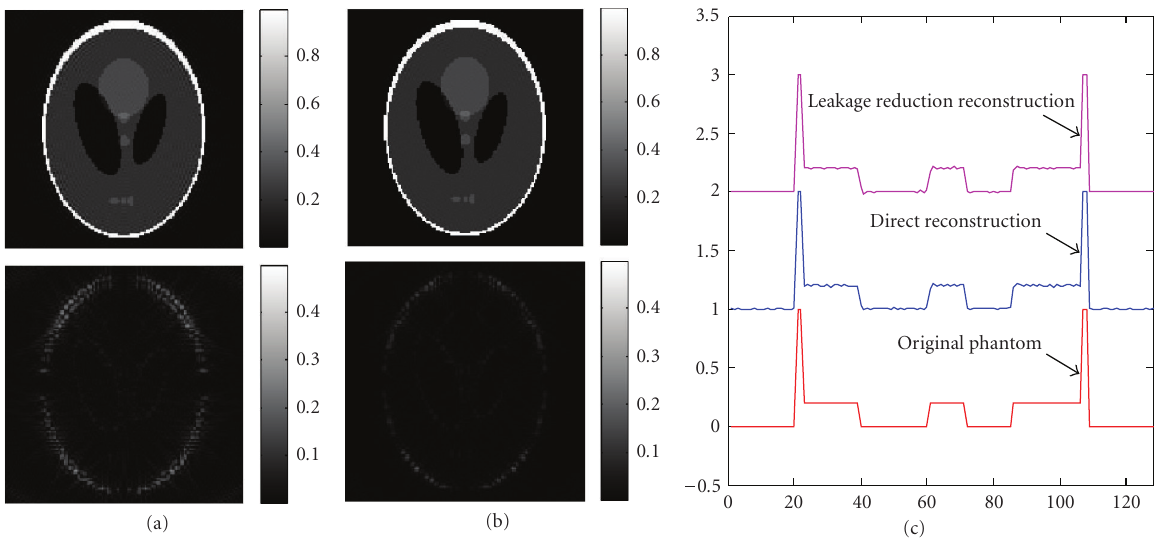
Figure 5: Reconstructed Shepp-Logan phantom images from radial samples and absolute di ff erence images using (a) direct reconstruction, and (b) leakage reduction reconstruction. (c) Center line profiles of the reconstructed images.